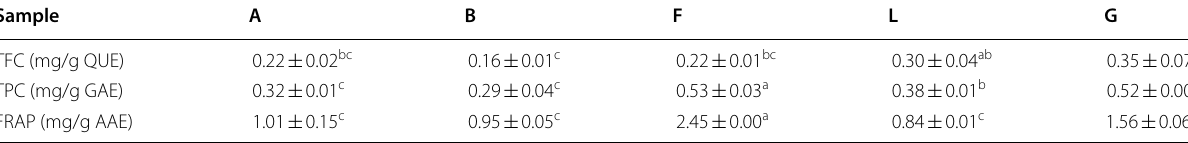
Mean standard deviation for three determinations. Values with different superscripts on a row are significantly different at p < 0.05 ± CSF: corn silk flour; LF: lemon flour; A: 100% CSF; B: 95% CSF and 5% LF; F: top tea; L: lipton tea; G: green tea TFC: Total flavonoid content; TPC: Total phenolic content; FRAP: Ferric reducing antioxidant